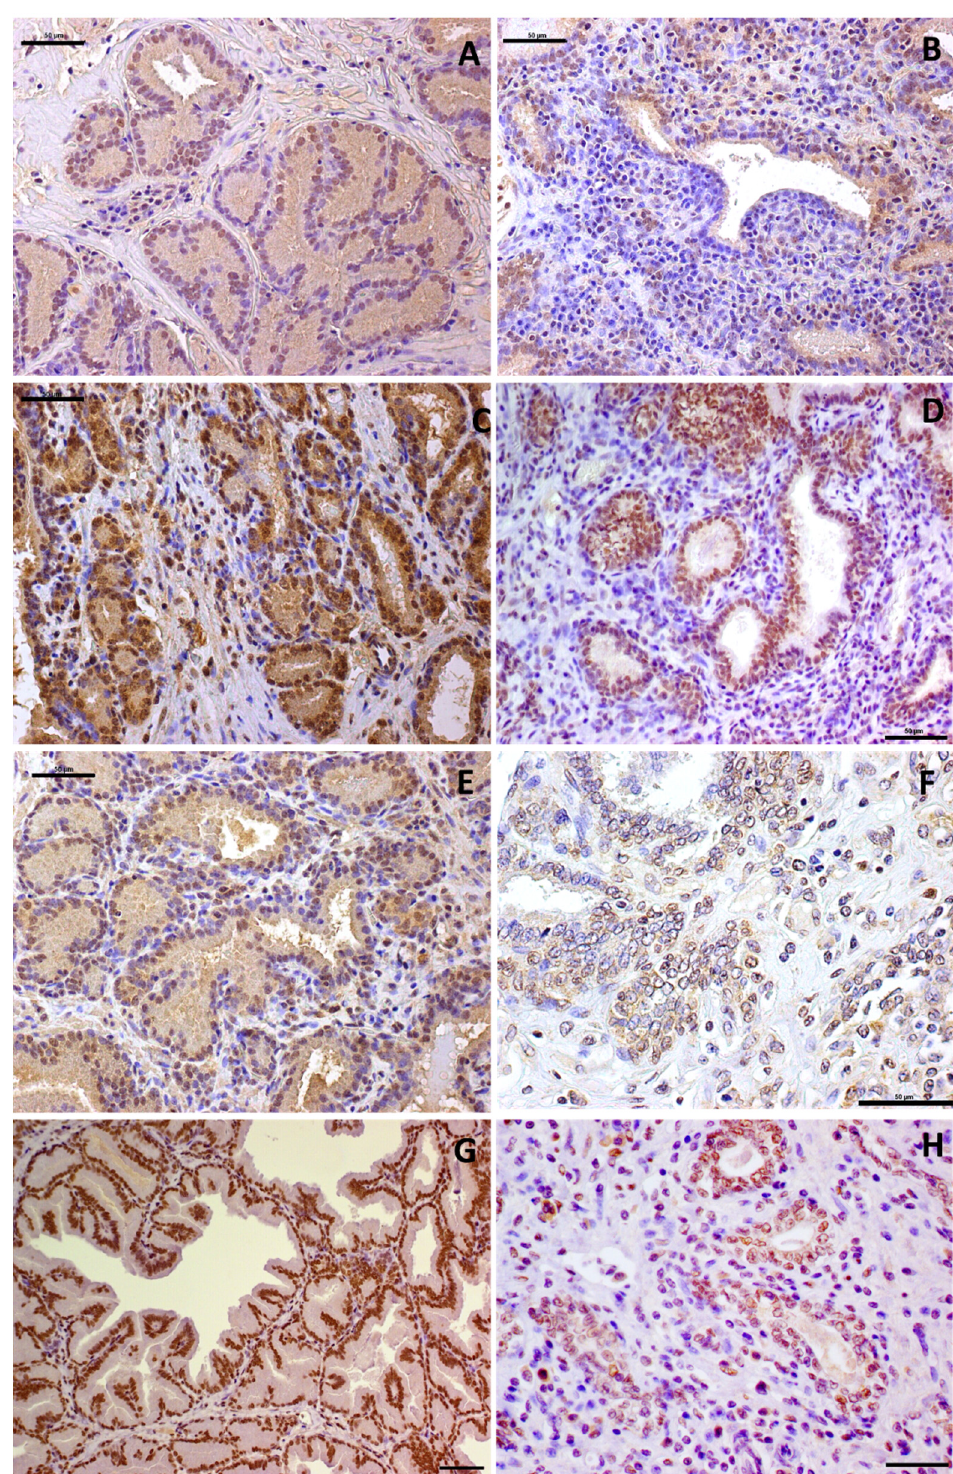
Figure 4. Immunohistochemical staining of the normal canine prostate and canine proliferative inflammatory atrophy (PIA). ( A ): PTEN expression in a canine normal sample: nuclear and cytoplasmic positive staining of luminal epithelial cells. ( B ): PTEN expression in proliferative inflammatory (PIA) samples: atrophic prostatic luminal cells with a lack of PTEN expression. ( C ): Nuclear and cytoplasmic P53 expression in a normal canine prostatic sample and ( D ): PIA lesions. ( E , F ): Positive cytoplasmic and nuclear MDM2 expression in normal ( E ) and PIA ( F ) samples. ( G , H ): nuclear androgen receptor (AR) expression in a normal prostatic sample and lack of expression in PIA samples ( H ). Counterstaining with Harris hematoxylin, DAB, 20×.